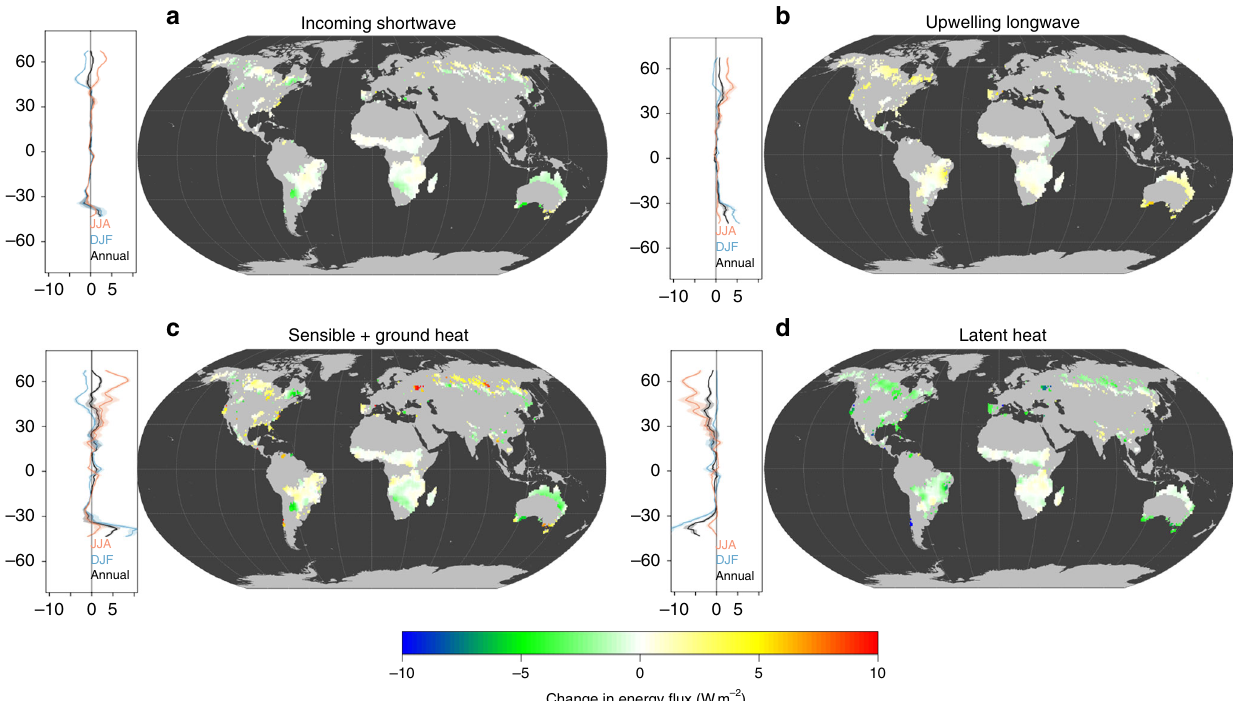
Fig. 4 Change in energy balance after one year after fi re. Immediate (1 year) impacts of fi re-induced forest loss on the surface energy fl ux as a result of changes in a incoming shortwave radiation ( △ SW in ), b upwelling longwave radiation ( △ LW out ), c the combination of sensible and ground heat fl uxes ( △ (HE + G)), and d the latent heat fl ux ( △ LE). For the latitudinal summaries of impacts, black lines represent annual impacts, red lines represent summer (June, July, August; JJA) impacts, and blue lines represent winter (December, January, February; DJF) impacts. The shaded areas are the mean ± one standard deviation. Panels a , b , c , d were created in the R environment for statistical computing and graphics (https://www.r-project.org/)